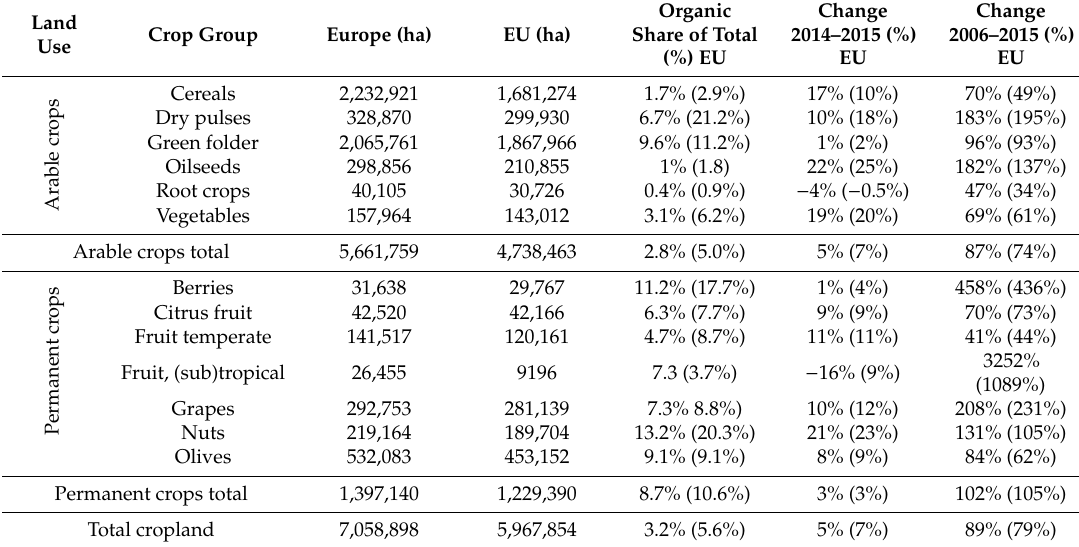
Source: FiBL-AMI survey 2016 based on national data sources and Eurostat